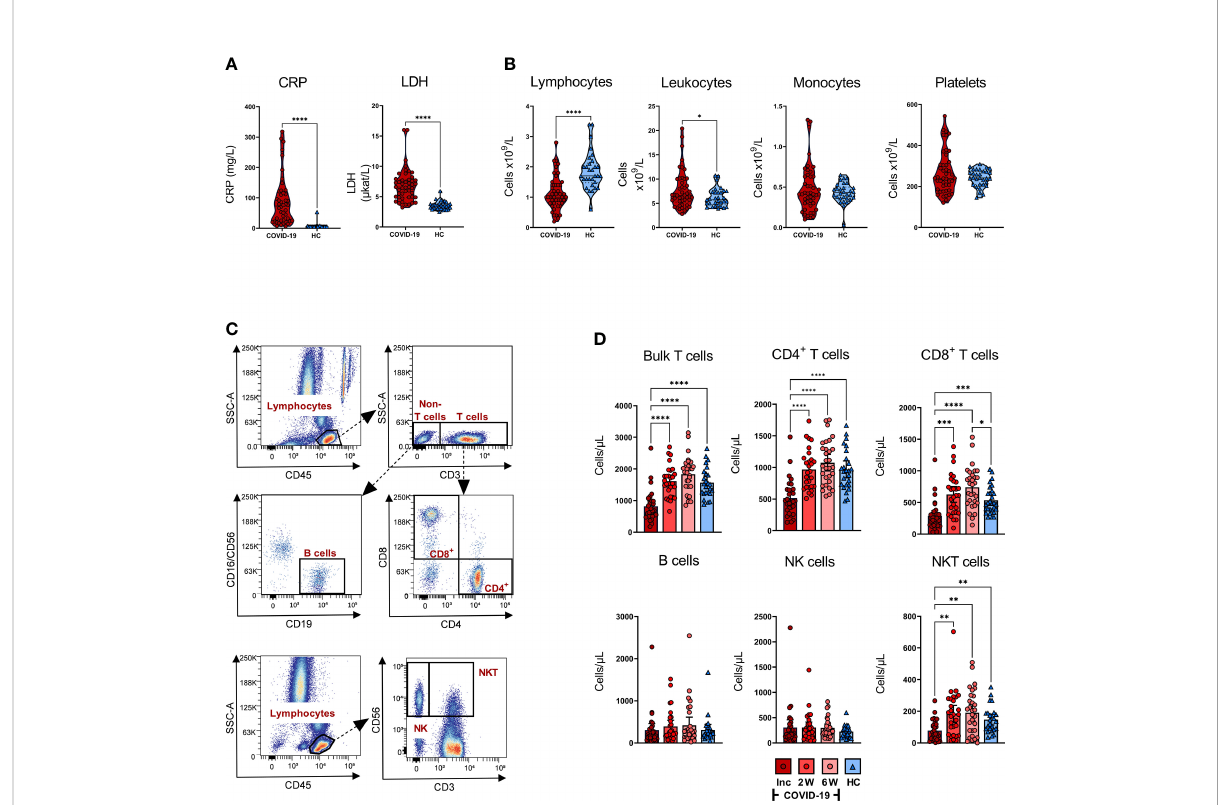
FIGURE 2 Effects of COVID-19 on clinical parameters and levels of white blood cells and platelets. Peripheral blood was collected from patients with COVID-19 that required hospitalization (N=46) and healthy controls (N=31), and levels of clinical markers and white blood cells were measured at inclusion. (A) The levels of CRP (mg/L), and LDH (µKat/L) were measured in blood of COVID-19 patients and healthy controls. (B) Lymphocyte, leukocyte, monocyte, and platelet counts in COVID-19 patients and healthy individuals at study inclusion were measured in blood as cells/particles x 10 9 /L. (C) Representative gating for quanti fi cation of T cell and B cell populations using truecount tubes with conjugated CD45, CD3, CD4, CD8, CD16/CD56 and CD19 monoclonal antibodies, and gating to determine proportions of NK cells and NKT cells using CD45, CD3, and CD56. (D) The absolute number of T cells, CD4 + T cells, CD8 + T cells, B cells, NK cells, and NKT cells per µL whole blood from COVID-19 patients and healthy individuals assessed by fl ow cytometry. The statistical testing was done by unpaired, parametric t test with Welch ’ s correction, or Brown-Forsythe and Welch ANOVA tests. *p ≤ 0.05, **p ≤ 0.01, ***p ≤ 0.001, ****p ≤ 0.0001. Inc = Inclusion in study at the hospital, 2W = 2 weeks, 6W = 6 weeks, HC = healthy